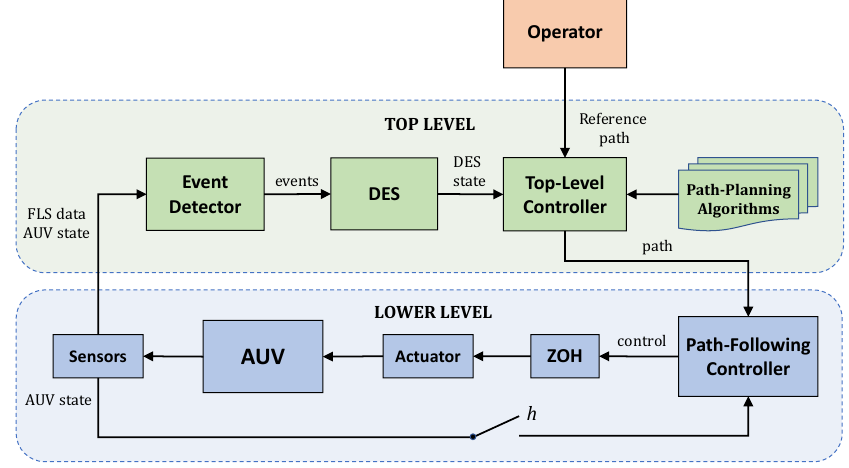
Figure 2. Control system